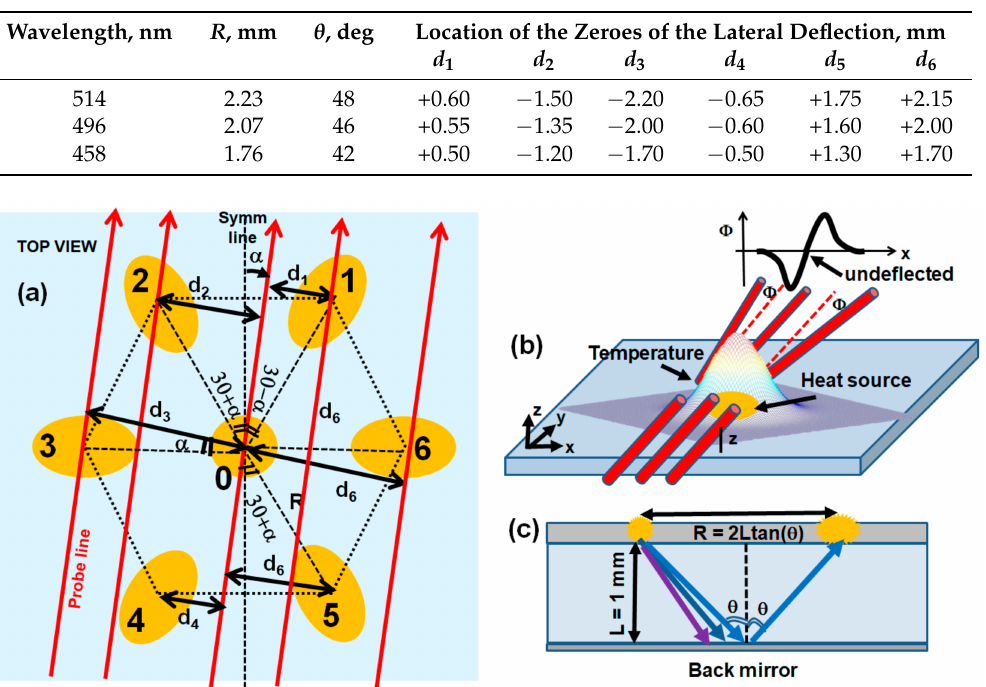
Table 1. Normal incidence: geometrical parameters of the heat sources produced by the absorption of the diffracted beams, as calculated from PDT data.